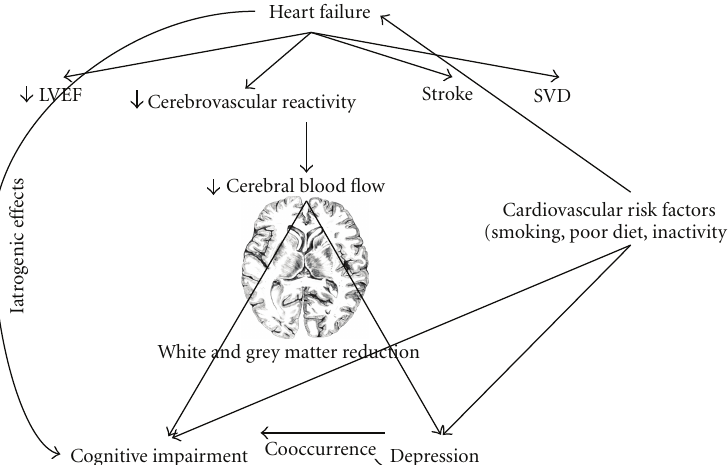
Figure 1: Relationship between CogI, depression, and HF. LVEF2: left ventricular ejection fraction; SVD: small vessels disease.